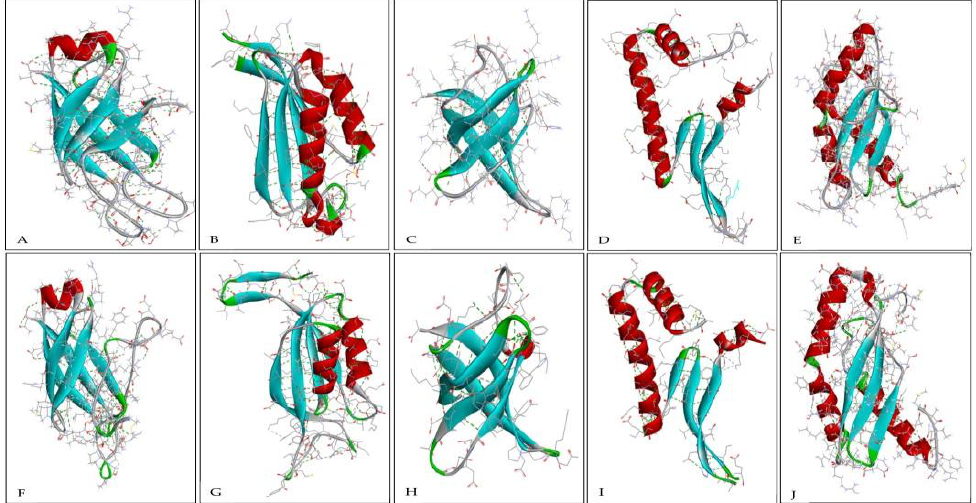
Figure 3. ( A – E ) show the structure of thermophilic protein Hsp40 chaperones, nitrogen regulatory protein, cold shock protein, DNA-binding protein HU and ribosome-binding factor A, respectively. ( F – J ) shows the structure of their non-thermophilic orthologs, respectively. Coil structure is shown in gray, helix in red, sheet in blue, and turn in green. Conventional hydrogen bonds are represented by the dotted green line, carbon-hydrogen bonds by the light green dotted line, and salt bridges by the dotted yellow line.